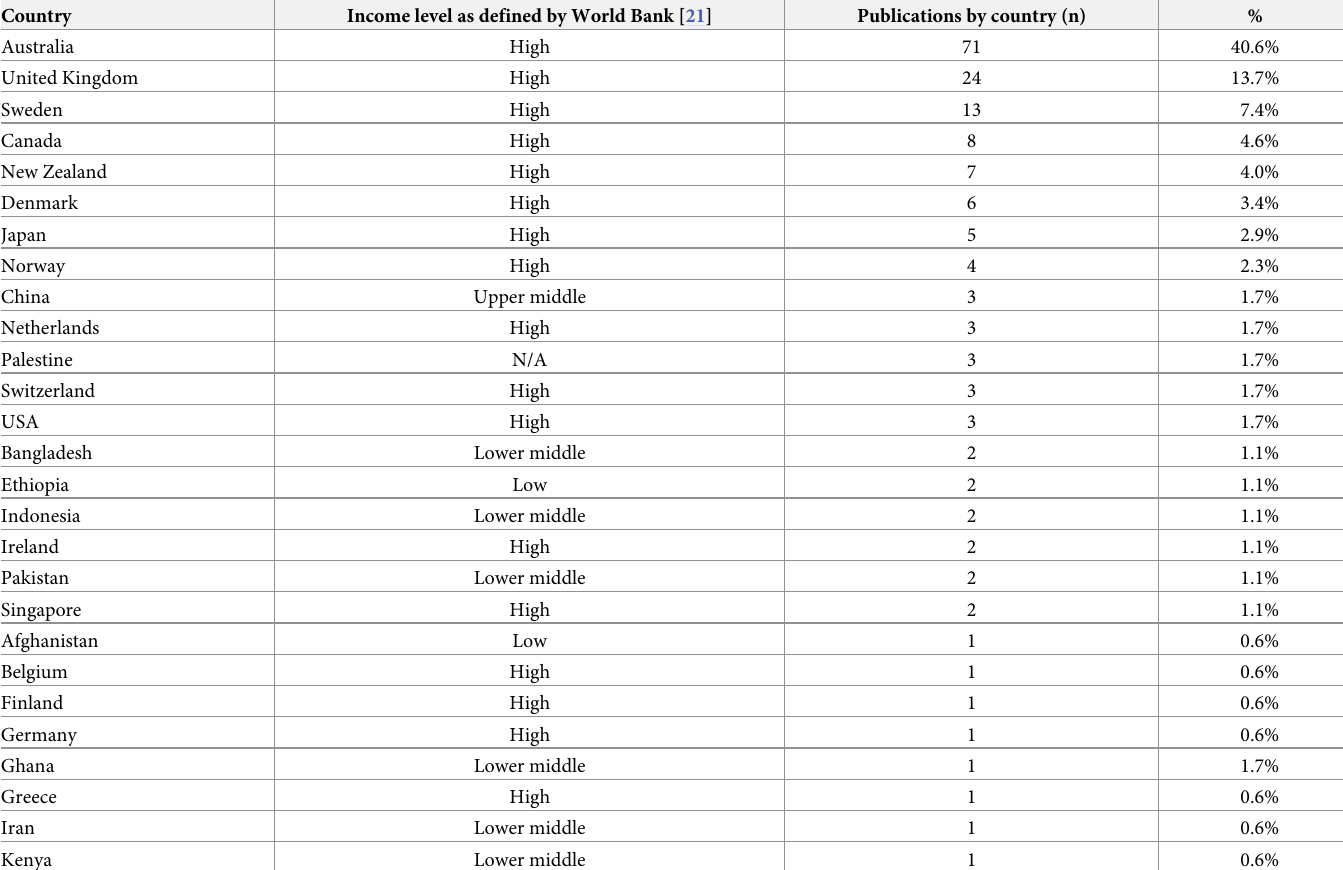
Table 1. Midwifery continuity of care publications by